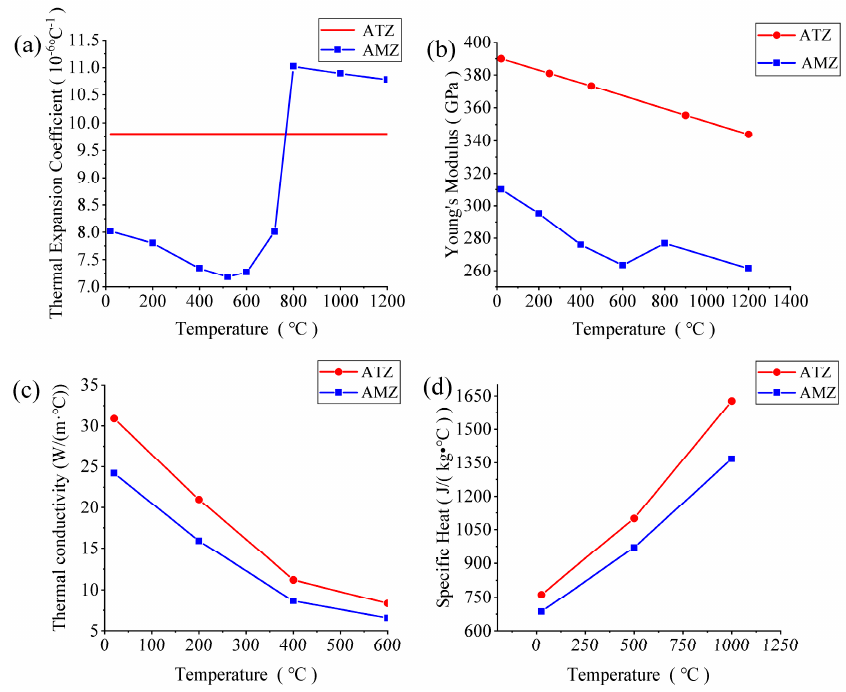
Figure 10. Curves of the ( a ) thermal expansion coefficient, α , ( b ) Young’s modulus, E , ( c ) thermal conductivity, k , and ( d ) specific heat, C p , of Al 2 O 3 /ZrO 2 -laminated ceramics versus temperature.